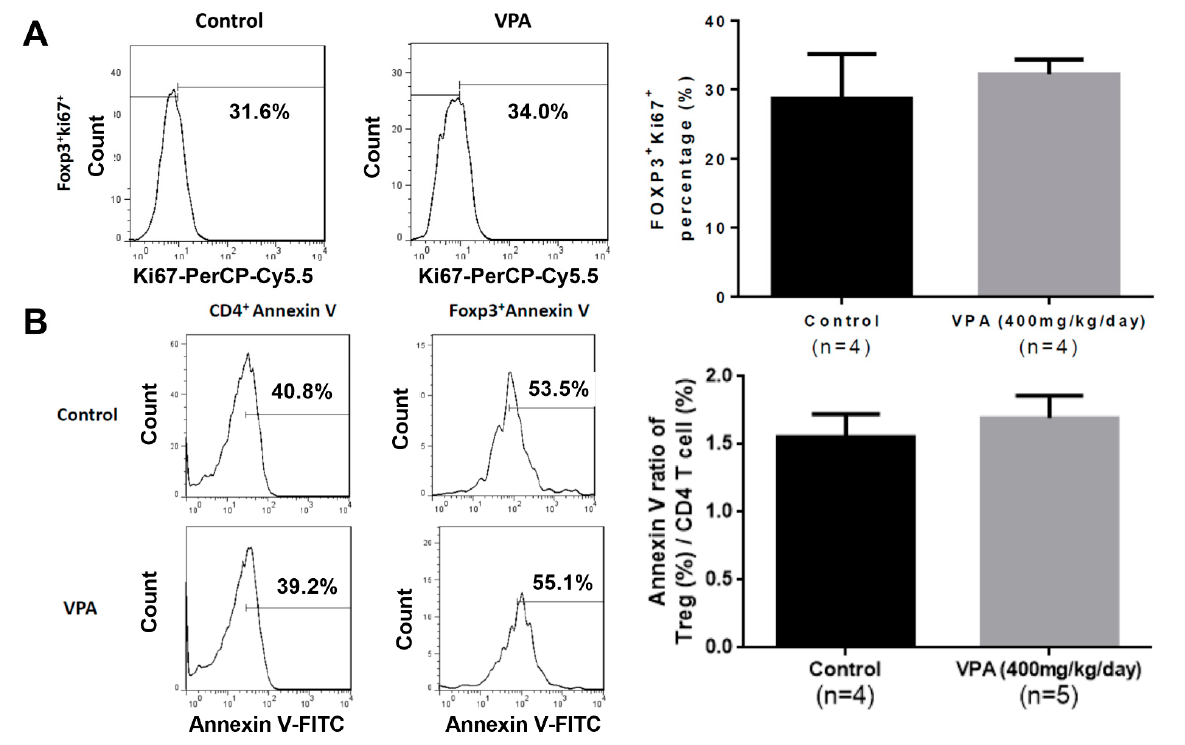
Figure 7. The effect of VPA treatment in the proliferation and apoptosis of Treg cells in the NOD recipients. ( A ) The proliferation of Treg cell was analyzed by the staining of proliferation marker Ki67. The percentage in the Ki67 + cells showed no significant difference. Data are expressed as the mean ± SEM. ( B ) The apoptosis of CD4 or Treg cells was analyzed by Annexin V staining. The ratio of Annexin V positive Treg cell and CD4 T cell showed no significant difference between control and VPA-treated group. Data are expressed as the mean ± SEM.